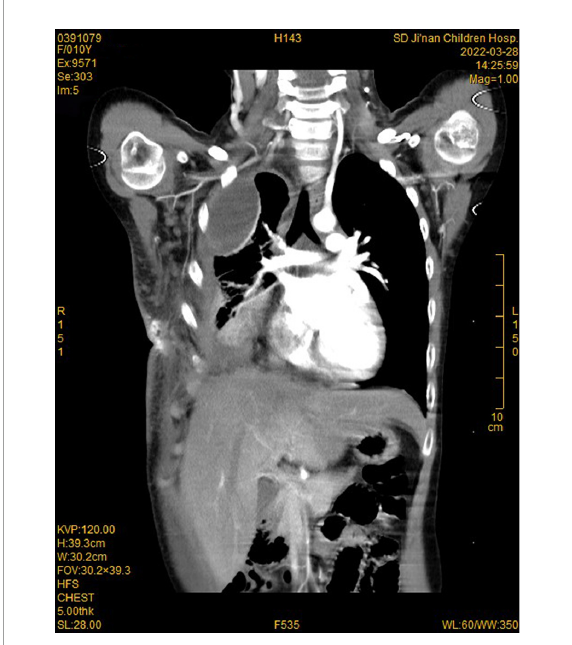
(PVA) of 300–500 µ m-diameter ( Supplementary Figures 1, 2